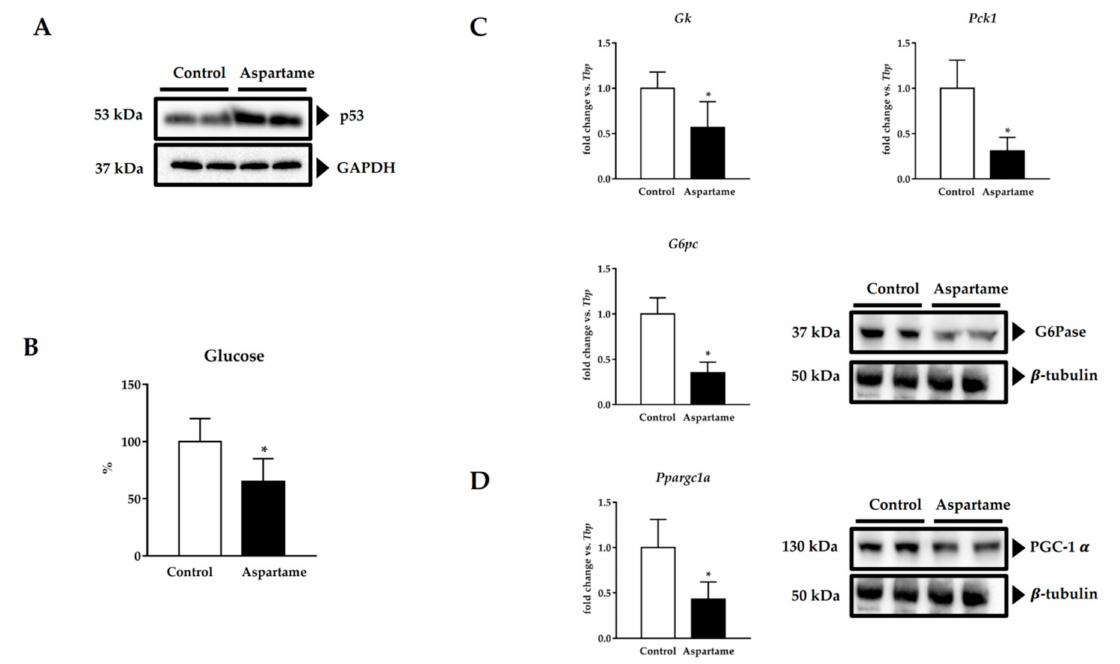
Figure 5. Representative images of Western blotting of p53 in the liver of control and aspartame-treated mice ( n = 4, each group). GAPDH was used as a loading control ( A ). Fasting glucose levels were measured by spectrophotometry in the serum of control and aspartame-treated mice ( n = 6, each group) ( B ). mRNA relative expression of gluconeogenic enzymes Gk , Pck1 , G6pc versus Tbp measured by RT-qPCR ( n = 6, each group) and representative image of Western blotting of G6Pase in the liver of control and aspartame-treated mice ( n = 4, each group). β -tubulin was used as a loading control ( C ). mRNA relative expression of Ppargc1a versus Tbp measured by RT-qPCR ( n = 6, each group) and representative image of Western blotting of PGC-1 α in the liver of control and aspartame-treated mice ( n = 4, each group). β -tubulin was used as a loading control ( D ). The statistical difference is indicated as follows: * p < 0.05 versus control.